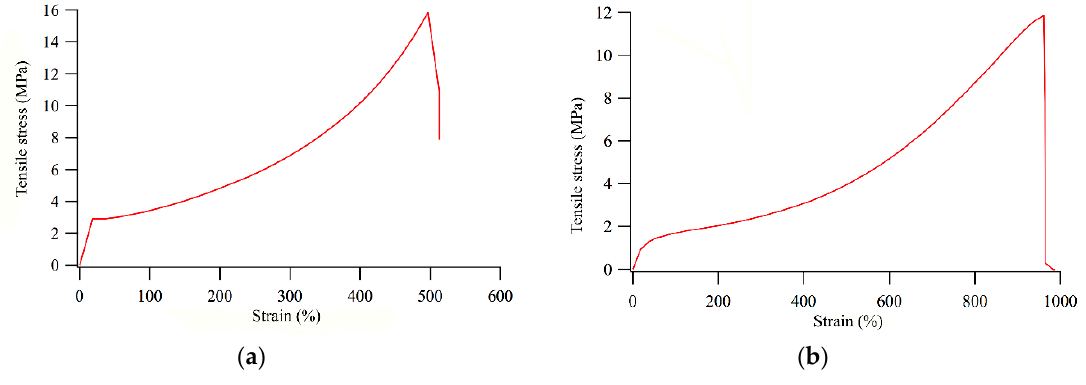
Figure 5. Stress-strain curves for E30-S27SzA3_100 ( a ) and E13-S27SzA3_100 ( b ). Table 4. Tensile test results for poly(styrene- b -(ethylene- co -butylene)- b -styrene) (SEBS)-based films and the corresponding SEBS (E30 / E30-MA and E13 / E13-MA) matrices.